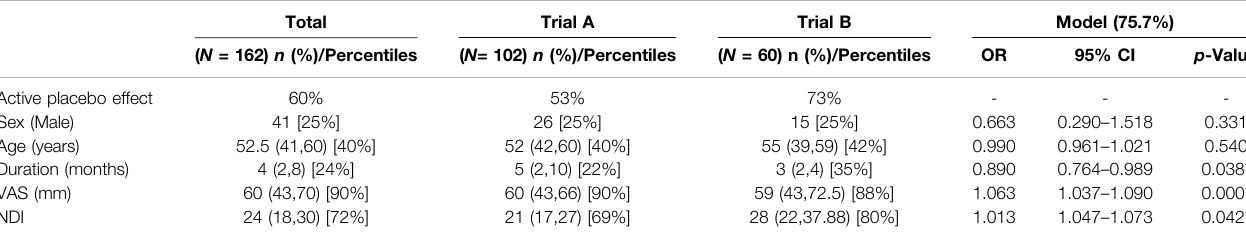
TABLE 2 | Summary and analysis of likely active placebo effect.